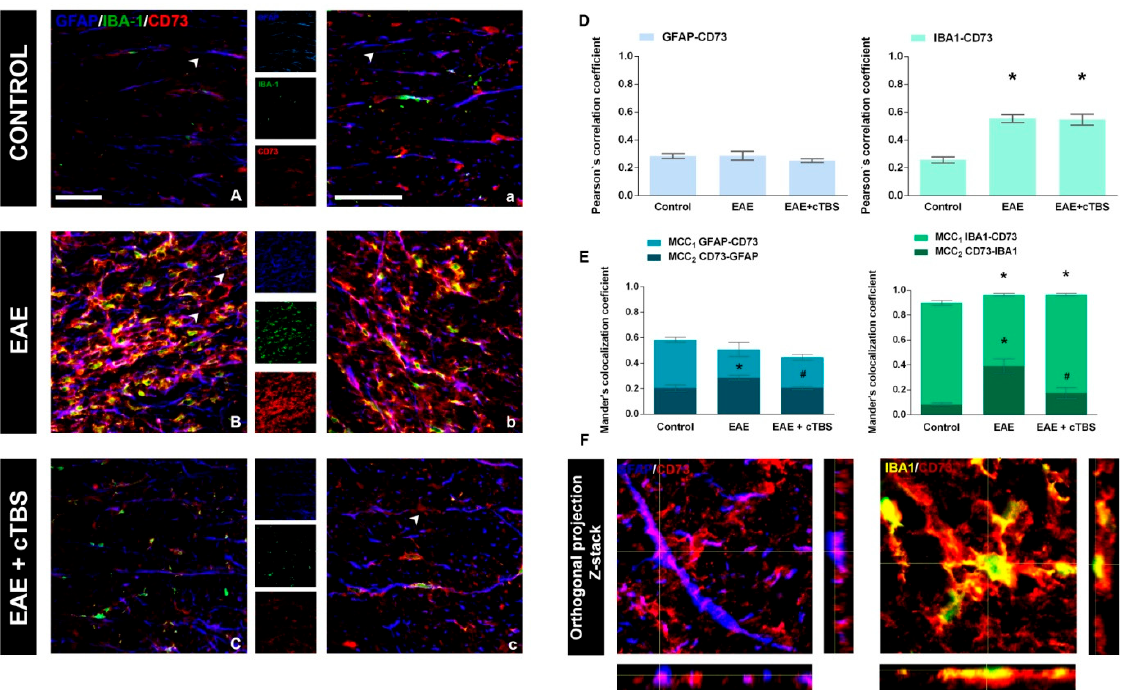
Figure 6. Effects of CTBS treatment on eN/CD73 expression in EAE rats. Triple immunofluorescence labeling directed to astrocyte marker GFAP (blue), microglial marker IBA-1 (green), and eN/CD73 (red). In control section, faint staining of eN/CD73 was observed colocalizing dominantly with GFAP + cells ( A,a ). In EAE sections, a marked increase in eN/CD73 staining was observed colocalizing with GFAP + and IBA-1 + cells ( B,b ). After CTBS treatment, a significant reduction in eN/CD73- ir was observed ( C,c ). Pearson correlation coefficients (PCC) indicating the level of signal overlap between GFAP- ir and eN/CD73- ir and IBA-1- ir and eN/CD73- ir . Bars show mean PCC ± SEM, from 7–9 images/animal ( D ). Mander’s colocalization coefficient (MCC) indicating level of signal colocalization between GFAP/CD73 (MCC 1 , light blue), CD73/GFAP (MCC 2 , dark blue), IBA-1/CD73 (MCC 1 , light green), and CD73/IBA1 (MCC 2, dark green) ( E ). Orthogonal Z-stack projection of GFAP/CD73 and IBA-1/CD73 ( F ). Level of significance: * p ˂ 0.05 or less when compared to control, # p ˂ 0.05 when compared to EAE. Scale bar corresponds to 50 µm.